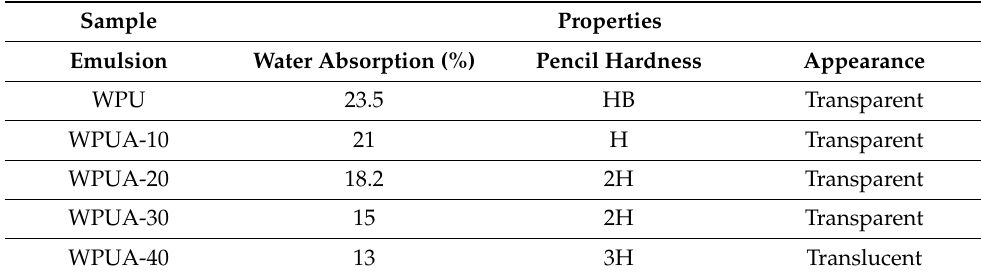
Table 2. Properties of the WPU and WPUA coatings.